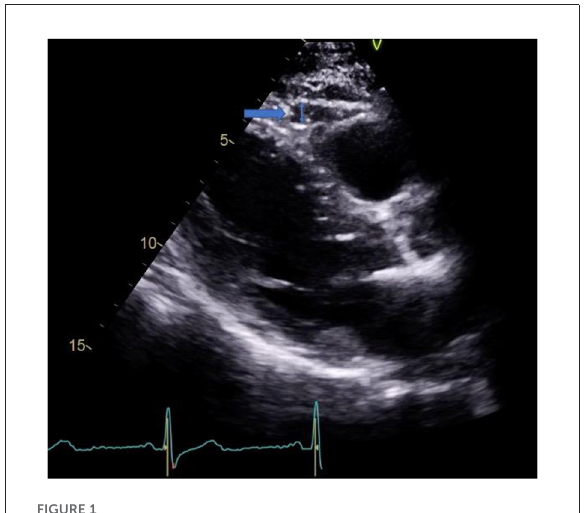
FIGURE1 EAT in parasternal long axis view.